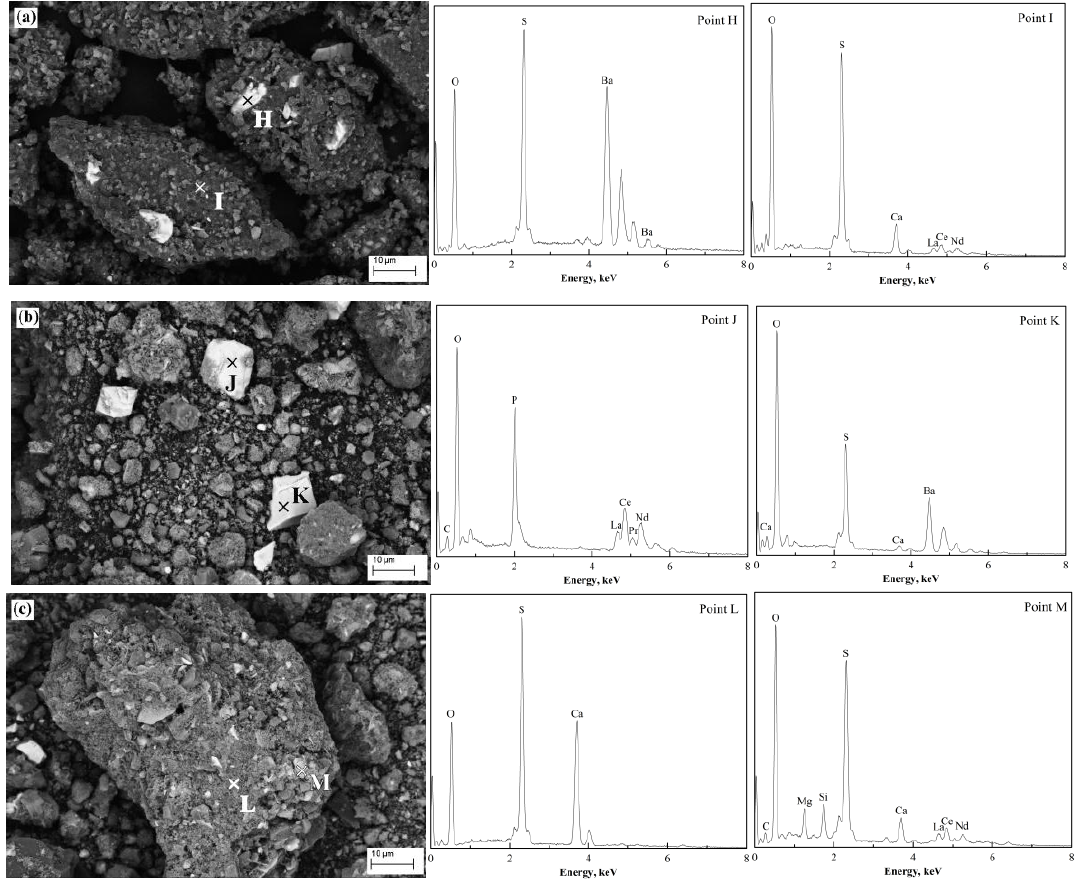
Figure 15. SEM image and EDS spectra of the (NH 4 ) 2 SO 4 activation roasting products: ( a ) 400 °C; ( b ) and ( c ) 500 °C.